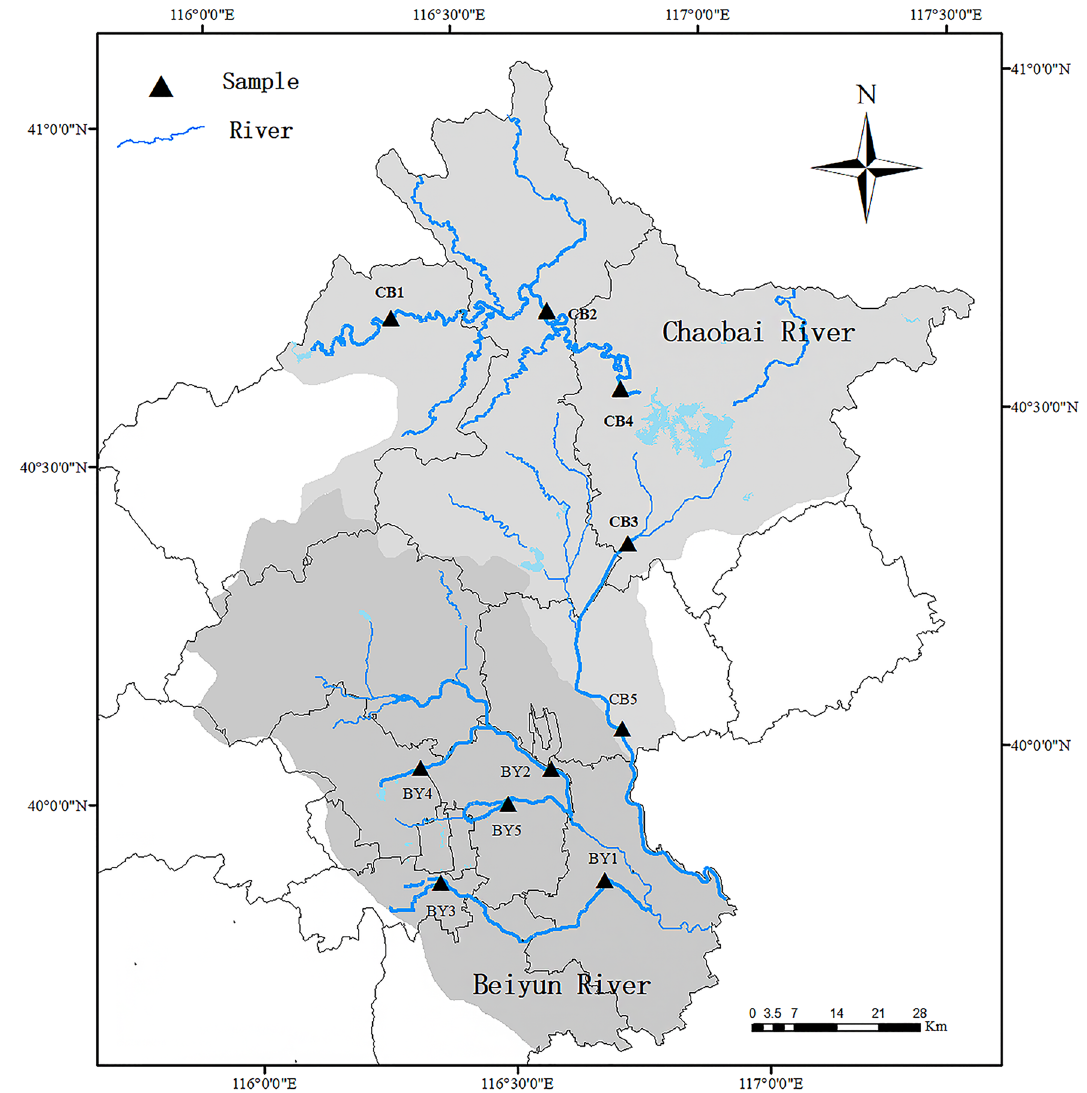
Figure 1. Sampling areas in Chaobai River ( light grey) and Beiyun River ( dark grey), with a total of 10 points. At each sampling point ( ▲ ), 3 L of water was used for eDNA while ground cages were used to capture fish. This map was created using Arcgis version 10.6 (https:// deskt op. arcgis. com/) based on the Resource and Environment Science and Data Center (https:// www. resdc. cn/ Defau lt. aspx), edited by Mei